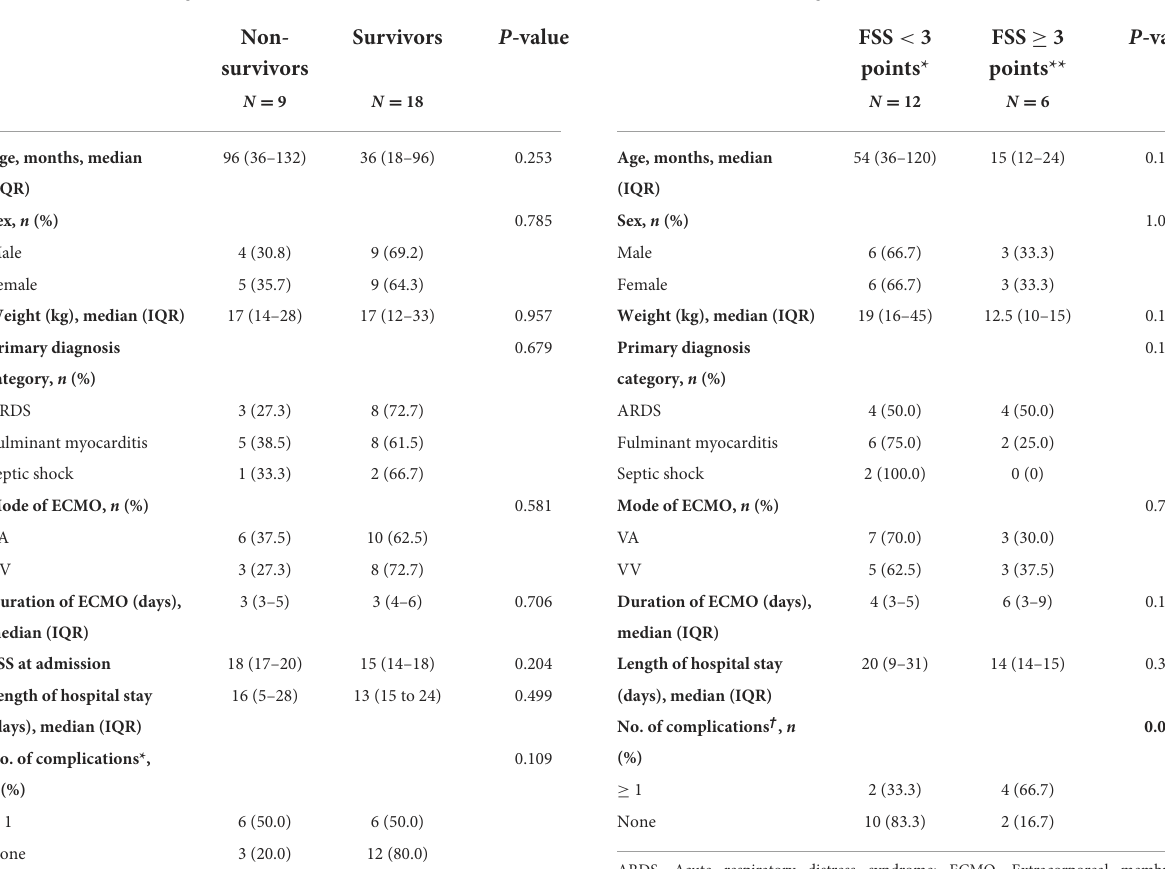
TABLE 3 Univariate analyses of clinical characteristics and survival. TABLE 4 Univariate analyses of clinical characteristics and FSS